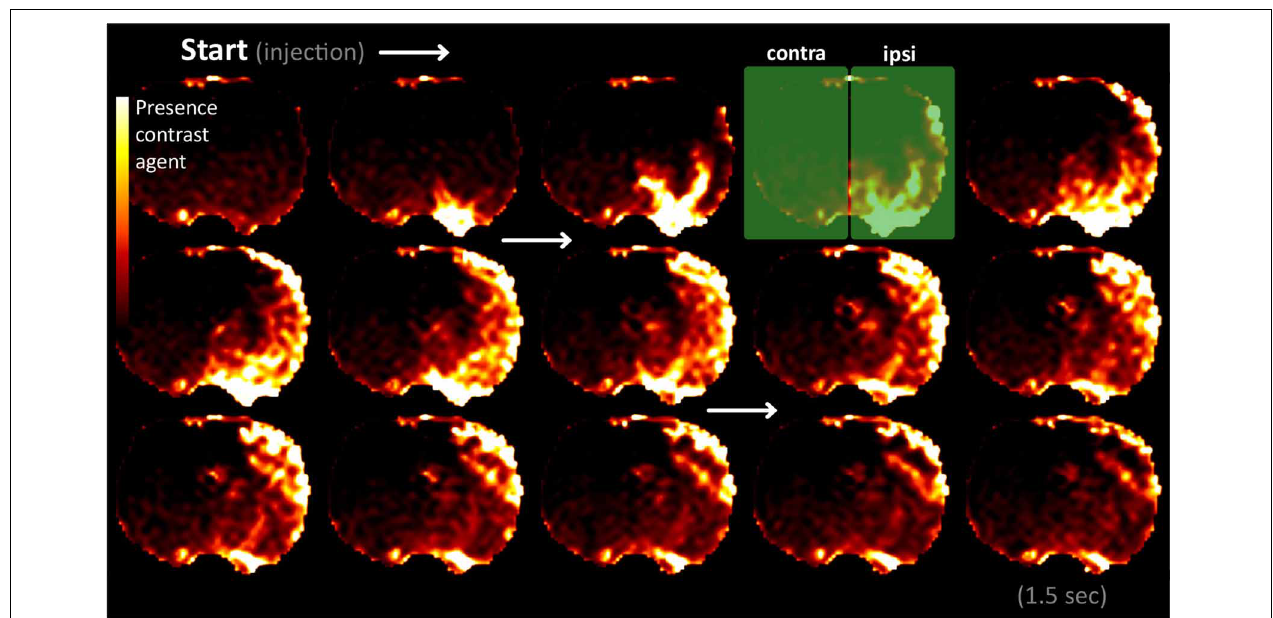
FIGURE 1 | Perfusion MRI frames, demonstrating clear unilateral delivery of the contrast agent in the hemisphere ipsilateral to the side of cannulation. The frames were acquired at 100ms intervals from the start of bolus administration until 1.5s later (the temporal frame sequence runs from